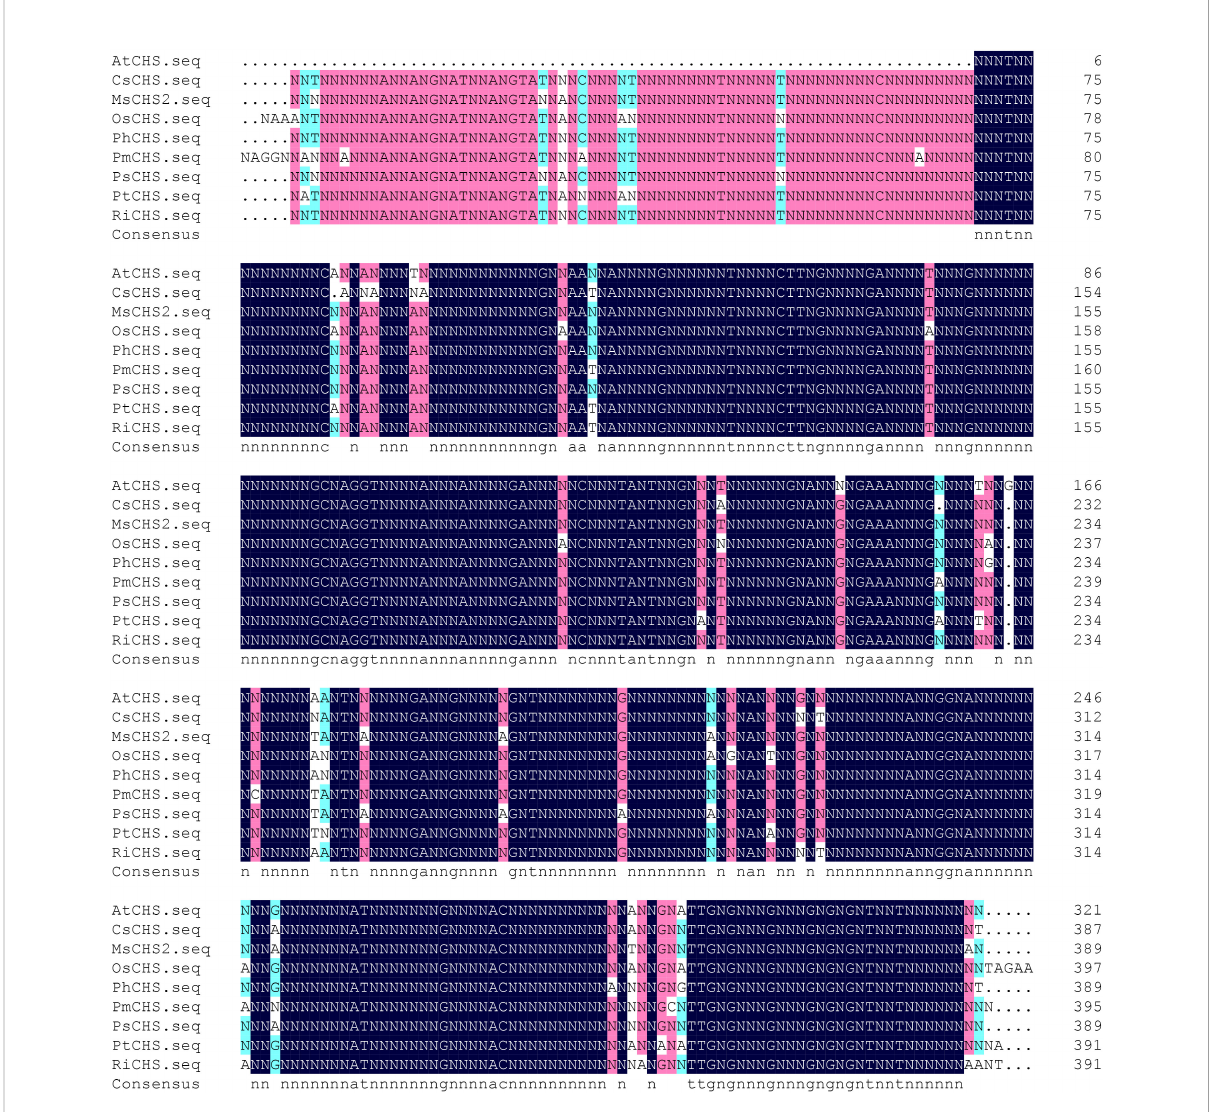
FIGURE 1 Sequence of PtCHS and its alignment with CHS gene of other plants. AtCHS, Arabidopsis thaliana ; CsCHS, Camellia sinensis ; MsCHS2, Medicago sativa ; OsCHS, Oryza sativ ; PhCHS, Petunia × hybrida ; PmCHS, Picea mariana ; PsCHS, Pisum sativum ; PtCHS, Poncirus trifoliata ; RiCHS, Rubus idaeus